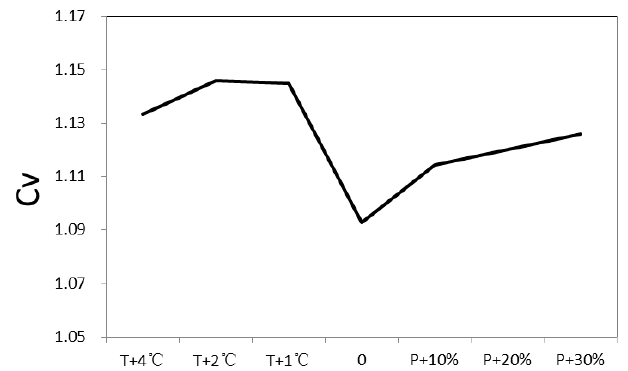
Figure 14. Coefficient variations ( C v) of mean daily glacial runoff under different surface change of temperature and precipitation.